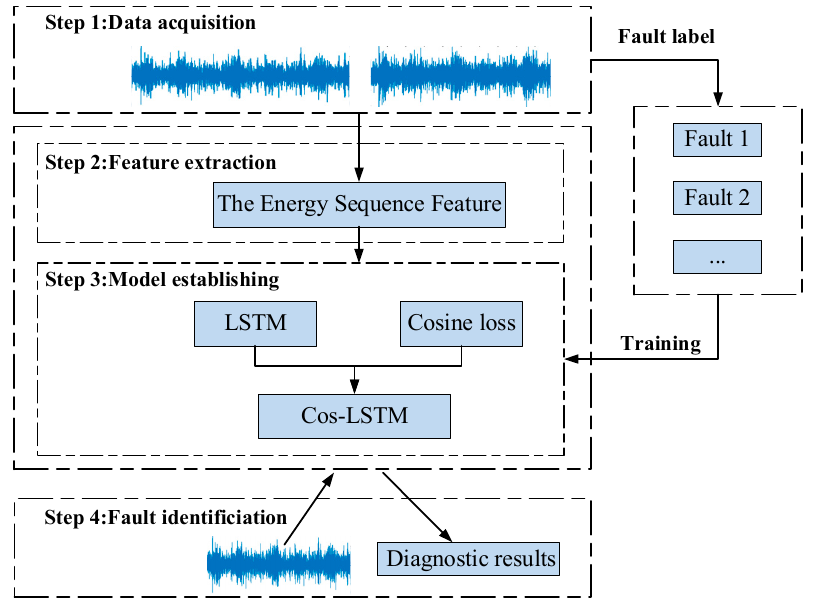
Figure 5. The workflow of the Cos-LSTM.